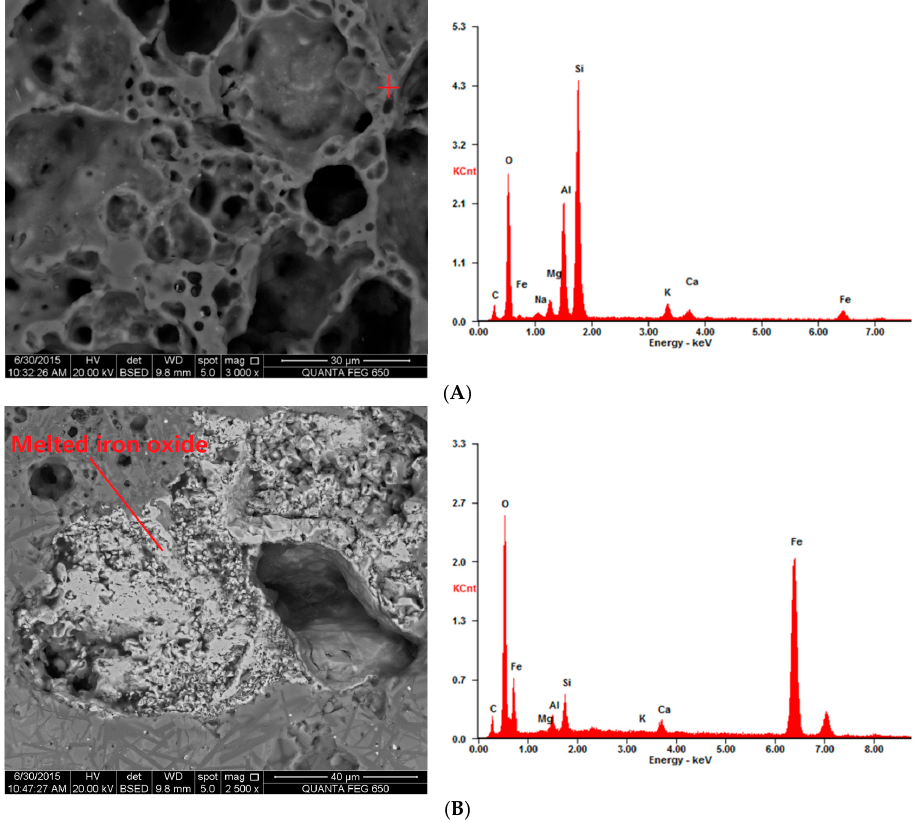
Figure 14. Cont. Figure 14.